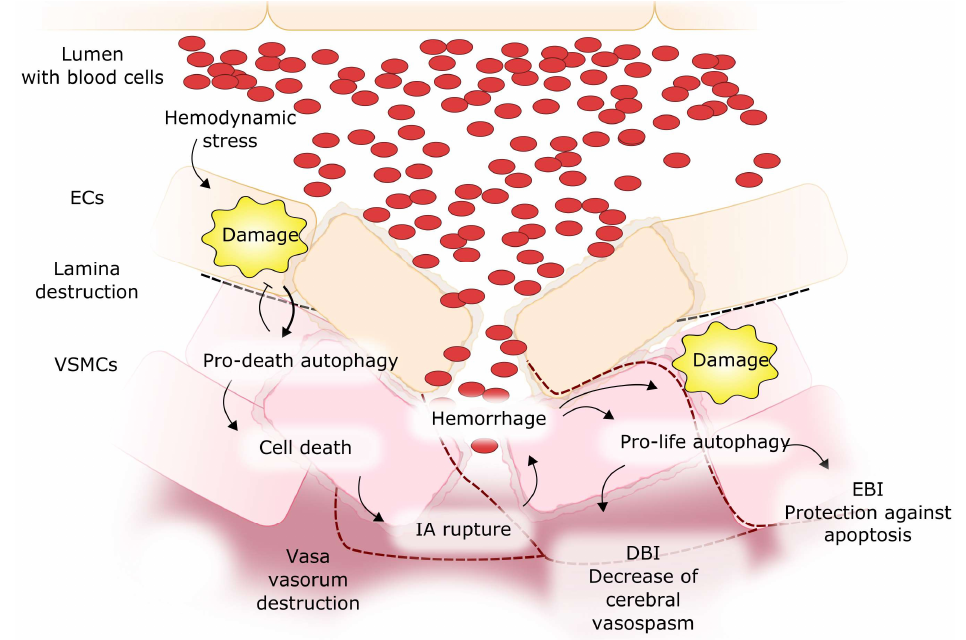
Figure 8. Involvement of autophagy in subarachnoid hemorrhage (SAH) resulted from rupture of an intracranial aneurysm and its consequent brain injury. Impaired pro-life autophagy can lead to the expansion of damage in endothelial cells (ECs) and vascular muscle smooth cells, by supporting the senescence of these cells and an antiapoptotic effect, which can lead to early brain injury (EBI). Pro-death autophagy can lead to cell death and thinning of EC and VSMC layers and thus participate in IA rupture. Cerebral vasospasm can be associated with delayed brain injury (DBI) after SAH, and autophagy can reduce this effect. Red dashed lines: vasa vasorum, black dashed lines: destroyed lamina.